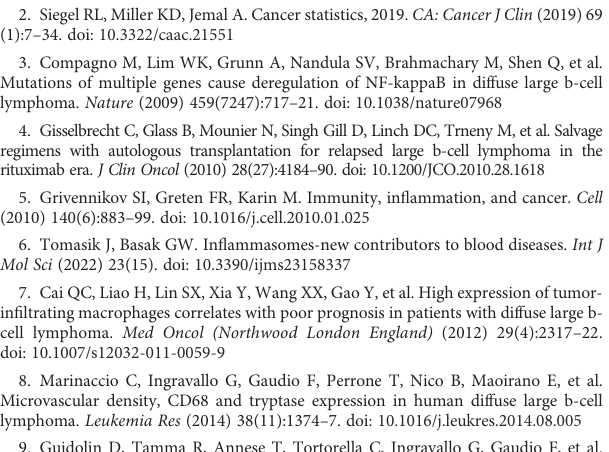
values. They were used for the GSEA analysis in Figure S1F. P ≤ 0.05 was considered signi fi cant. SUPPLEMENTARY TABLE 3 List of the characteristics of the patients whose tumor samples were included in the tissue microarray used for the immunohistochemistry analysis.